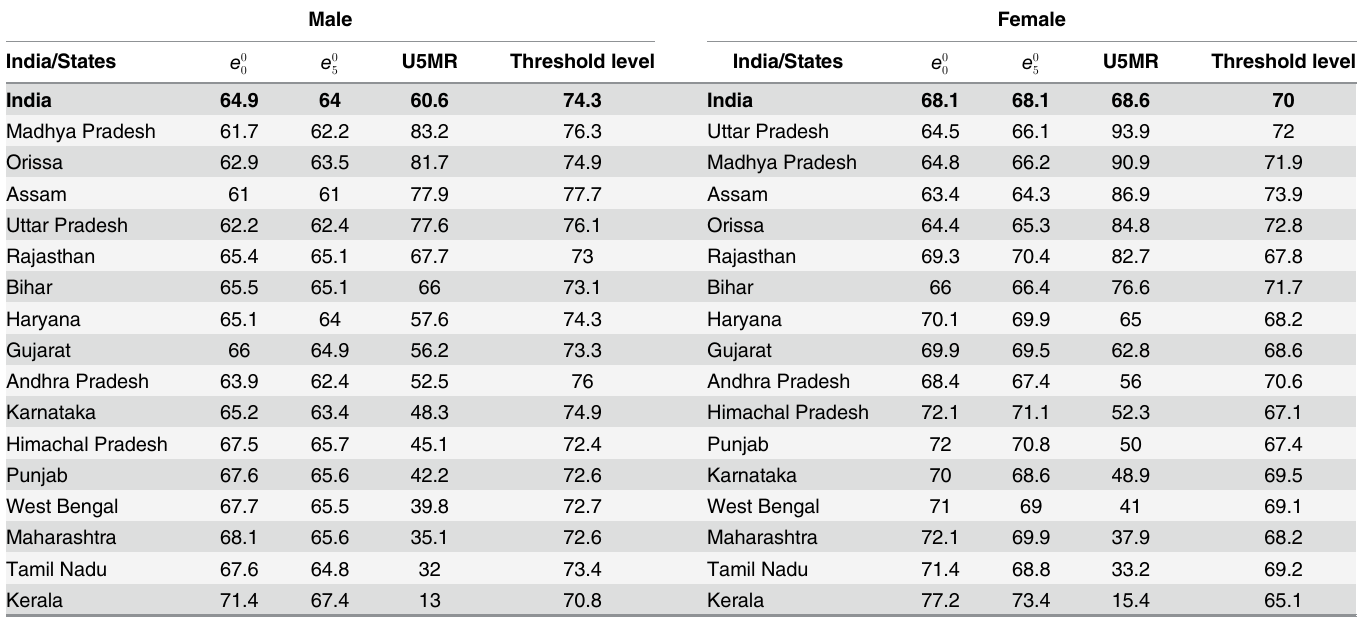
Table 2. Life expectancy at age zero and five, under-five mortality rate and its threshold level by sex, India and states,